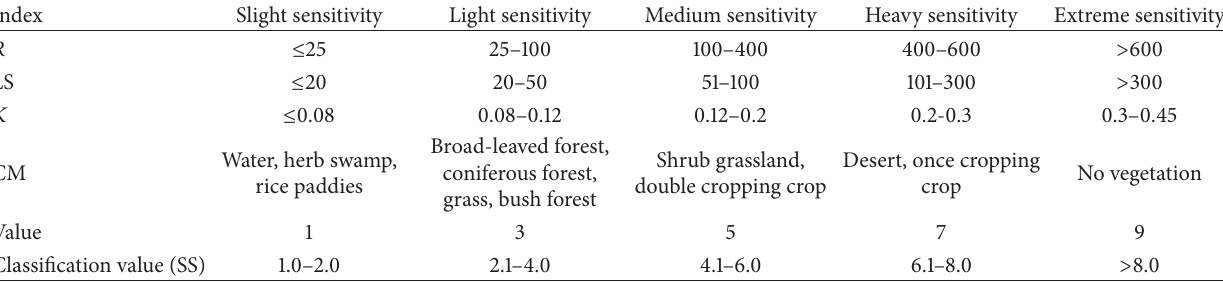
Table 2: Soil erosion sensitivity standard classification.